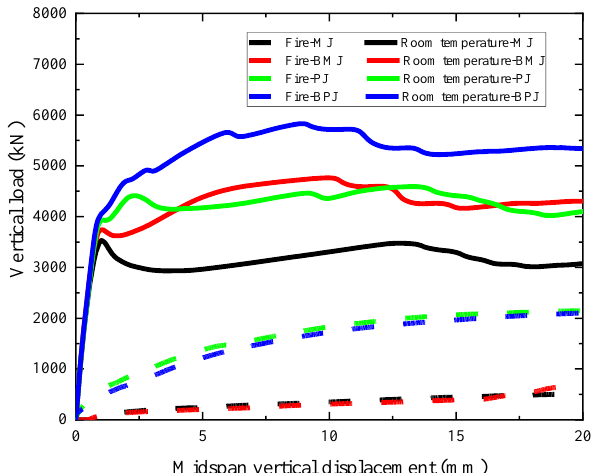
Figure 12. Load – displacement curves of four joints under fire exposure and at room temperature. Figure 12. Load–displacement curves of four joints under fire exposure and at room